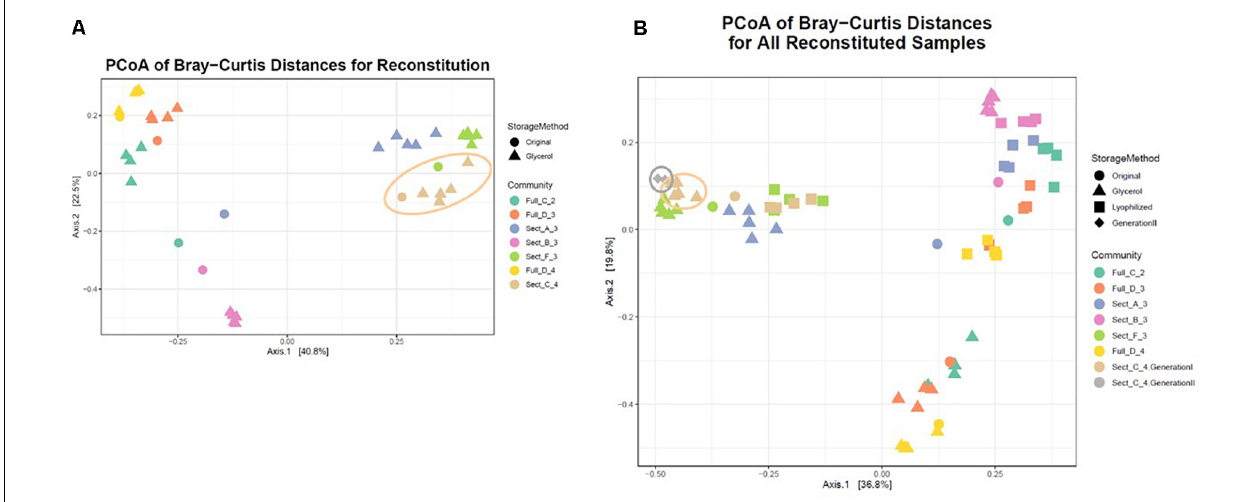
FIGURE 5 | Bray-Curtis distances of all consortia and reconstituted stocks. (A) Each parent consortium is shown as a colored circle, colors for each consortium are shown on the right. Each glycerol stock is shown as a colored triangle with colors that match its parent consortium. Consortium C2 (the origin of MSC-1) is indicated with a beige outline. (B) Similar to (A) but lyophilized stocks of each consortium are also included (colored squares). Also shown is Generation 2 of C2 (gray diamonds). Generation 1 of C2 is indicated with a beige outline and Generation 2 of C2 is indicated with a gray